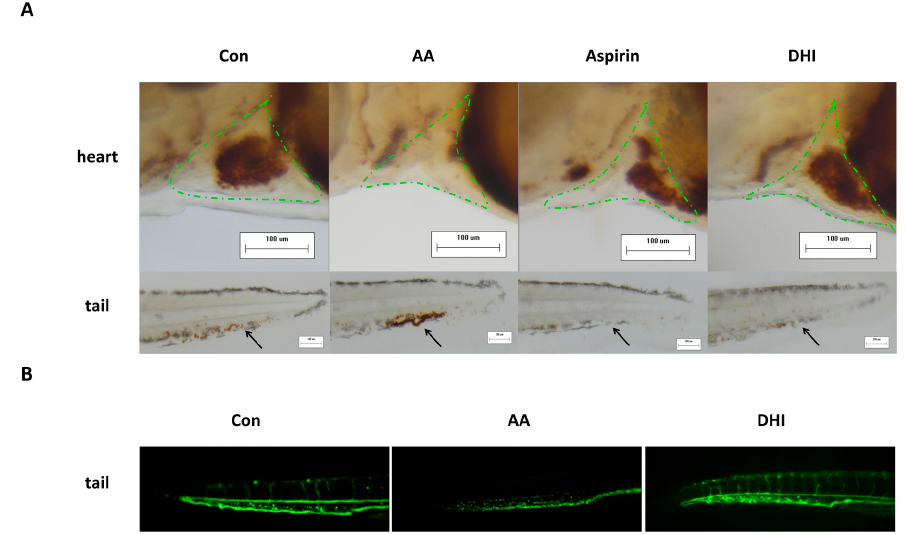
Figure 1. ( A ) Heart red blood cells (green dashed line) and tail venous thrombus (black arrows) stained with o -dianisidine in the zebrafish of the control group, AA group (AA 40 μ M), positive drug group (aspirin 22.5 μ g/mL), and DHI (100 μ L/mL) group, at a 100× magnification; ( B ) Tail venous thrombus in the transgenic LCR-GFP zebrafish of the control group, model group (AA 40 µ M), and DHI (100 µ L/mL) group, at a 100 × magnification. Con, AA, DHI and LCR-GFP stand for control, arachidonic acid, danhong injection, and locals control region-green fluorescence protein